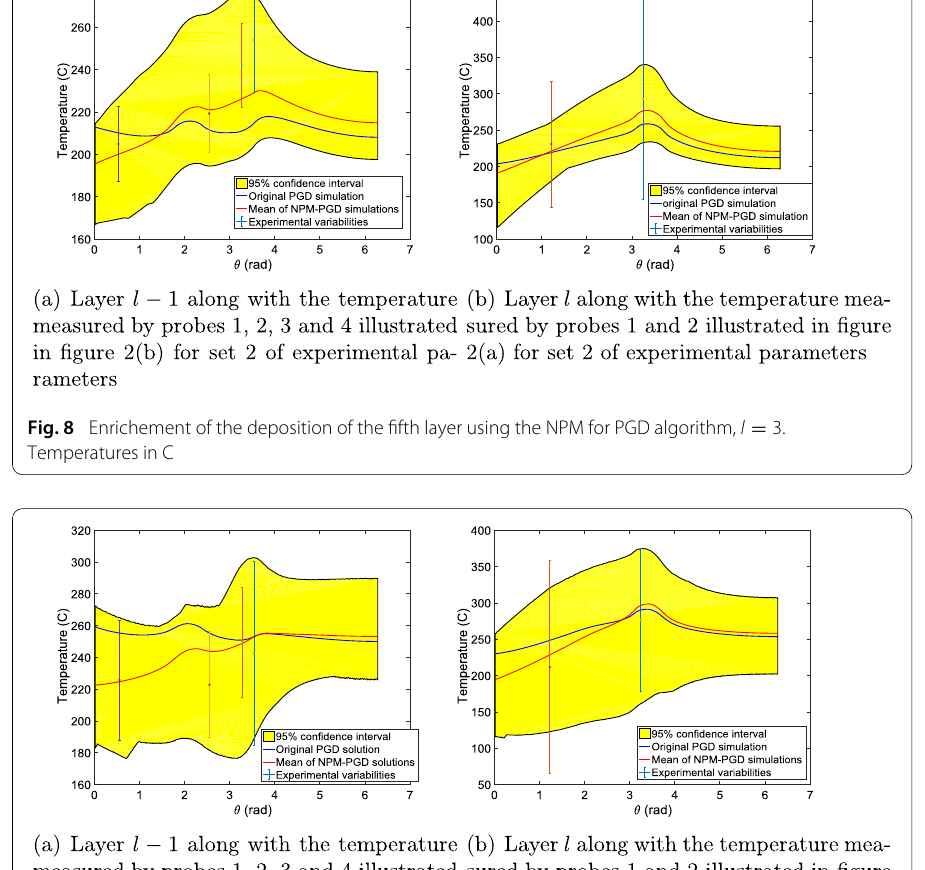
Fig. 9 Enrichement of the deposition of the fifth layer using the NPM for PGD algorithm, l = 5. Temperatures in